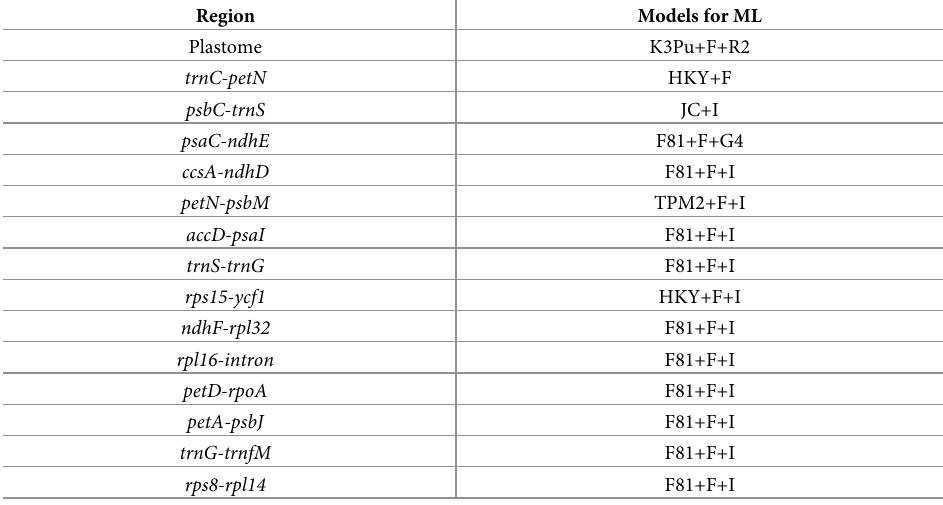
Table 1. Substitution models selected for the phylogenetic inferences using Maximum Likelihood